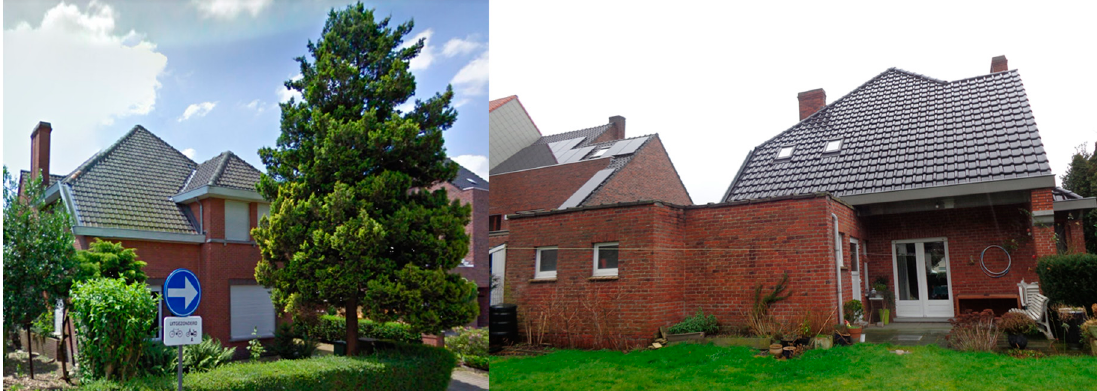
Figure 1. Front facade ( left ) and back facade ( right ) of the case study building.